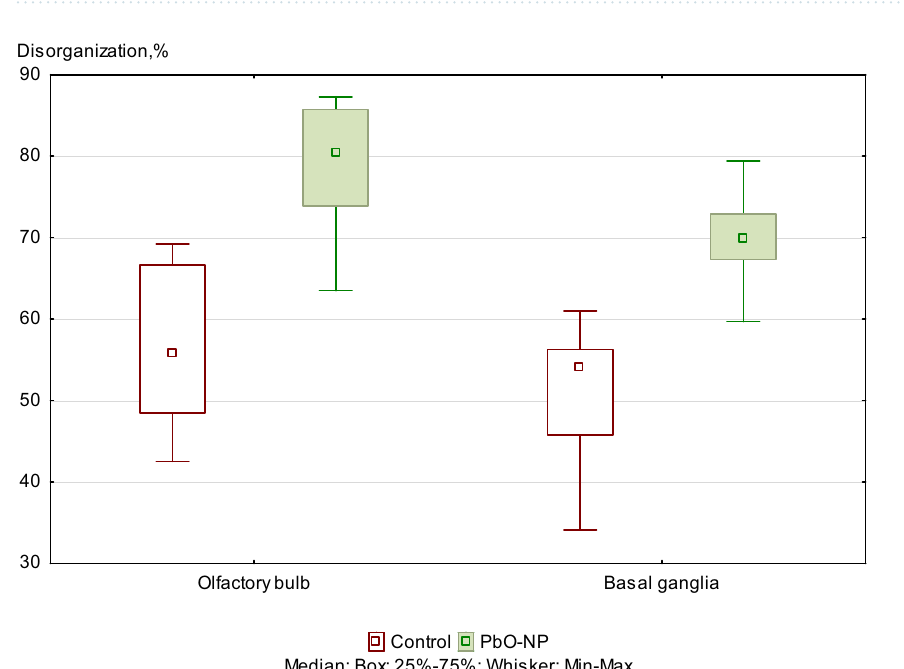
Figure 3. Damages to the ultrastructure of myelin sheaths of axons in the control and PbO NPs exposure groups of rats. Note: Values are given as a fraction of axons with damaged sheaths in the total number of axons detected. Significant differences in damage to the ultrastructure of the myelin sheaths of axons between brain regions in both groups were not